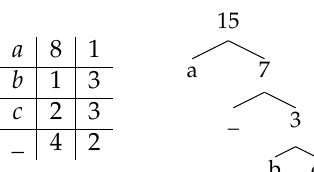
Figure 2. Illustrations for the instance based on the text T = “aaaaaaaabcc____”, maximizing the number of occurrences of “EI” in its EI signature S ( T ) = “E EI EI EI”. The columns of the array respectively list the messages, their numbers of occurrences and the code lengths assigned to